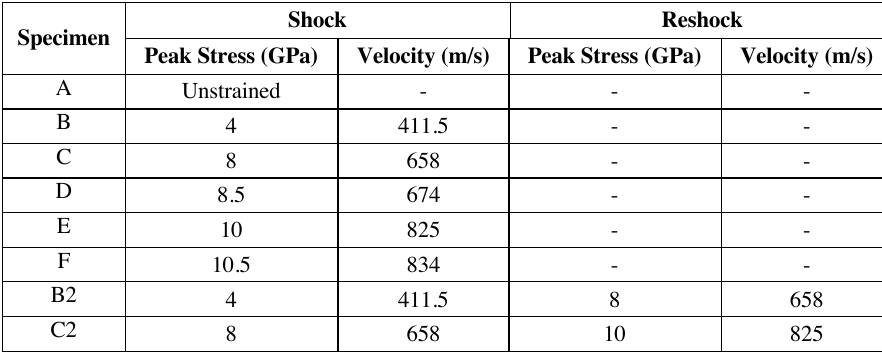
Table 2. Matrix of shocked and soft-recovered samples of high-purity Zr.